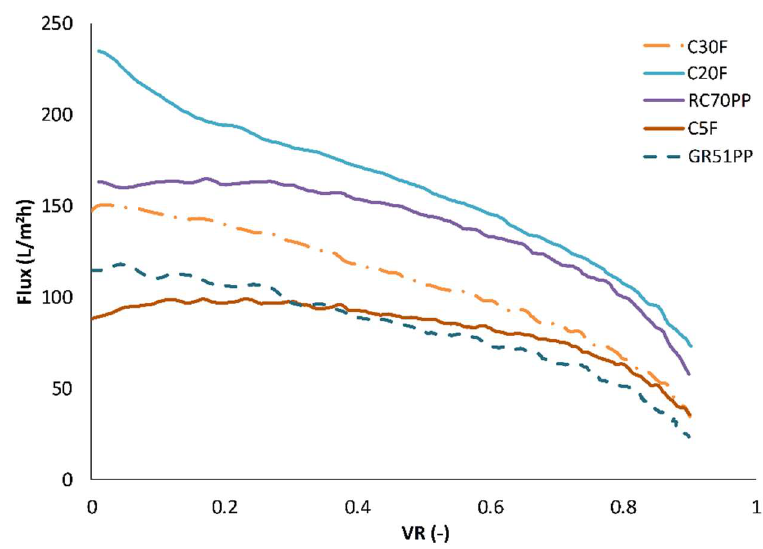
Figure 4. Flux vs volume reduction (VR) curves for the different concentration studies performed using the hydrophobic and hydophilic membranes. The temperature, trans-membrane pressure and cross-flow velocity were 50 °C, 5.5 bar, and 0.5 m/s, respectively.